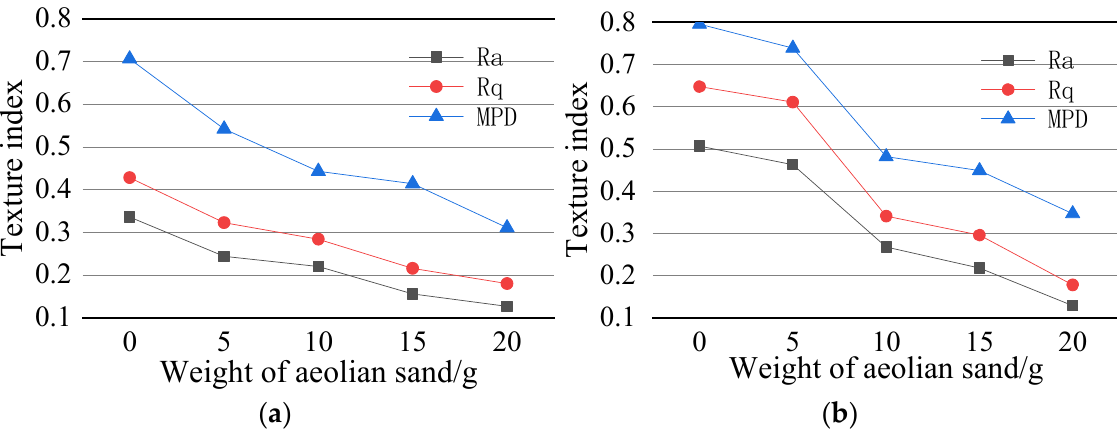
Figure 13. Texture index under different sand accumulation. ( a ) Texture index under different sand accumulation on the AC-13 pavement surface; ( b ) texture index under different sand accumulation on the AC-16 pavement surface.